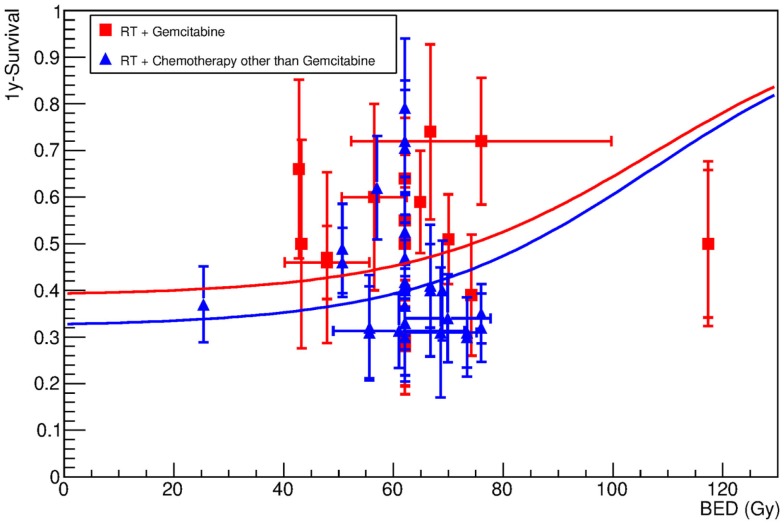
One-year survival as a function of the BED for patients undergoing X-ray radiotherapy plus gemcitabine (red symbols), or other chemotherapy drugs (blue symbols). Data are reported in Tables 2 and 4. The lines show the result of the fit (Eq. 3), which was performed assuming that γ50 and D50 are obtained by fitting the data in treatments using radiotherapy only (Figure 1). The only free fitting parameter is the chemotherapy survival CS (see Table 3). The results suggest that the final outcome does not strongly depend on the specific chemotherapy treatment, although some advantage seems to be associated to the use of gemcitabine.